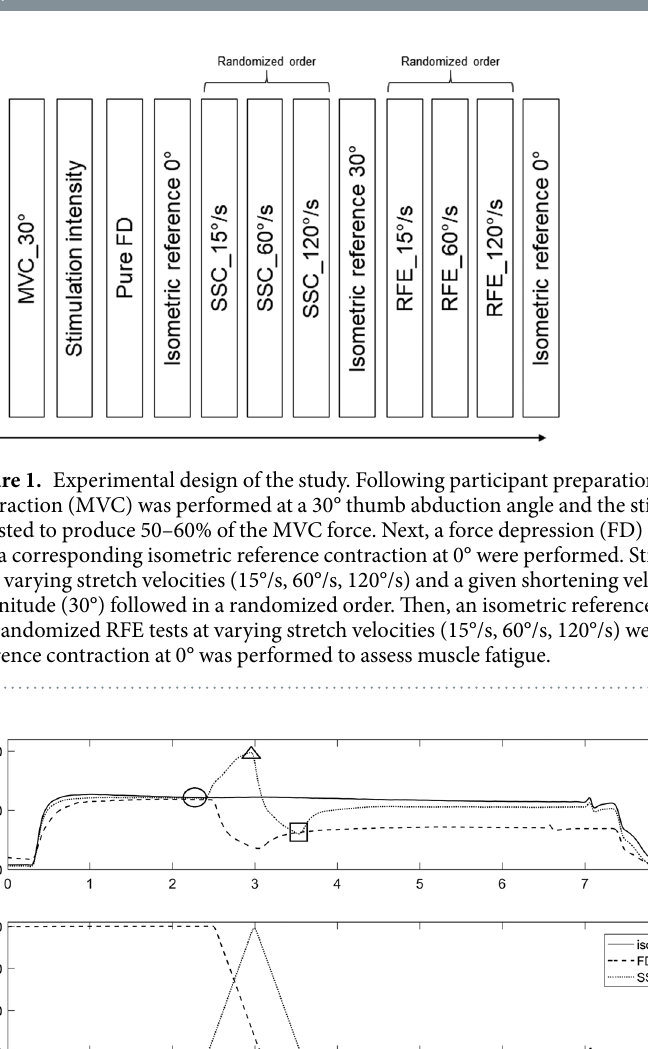
Data reduction and analysis.